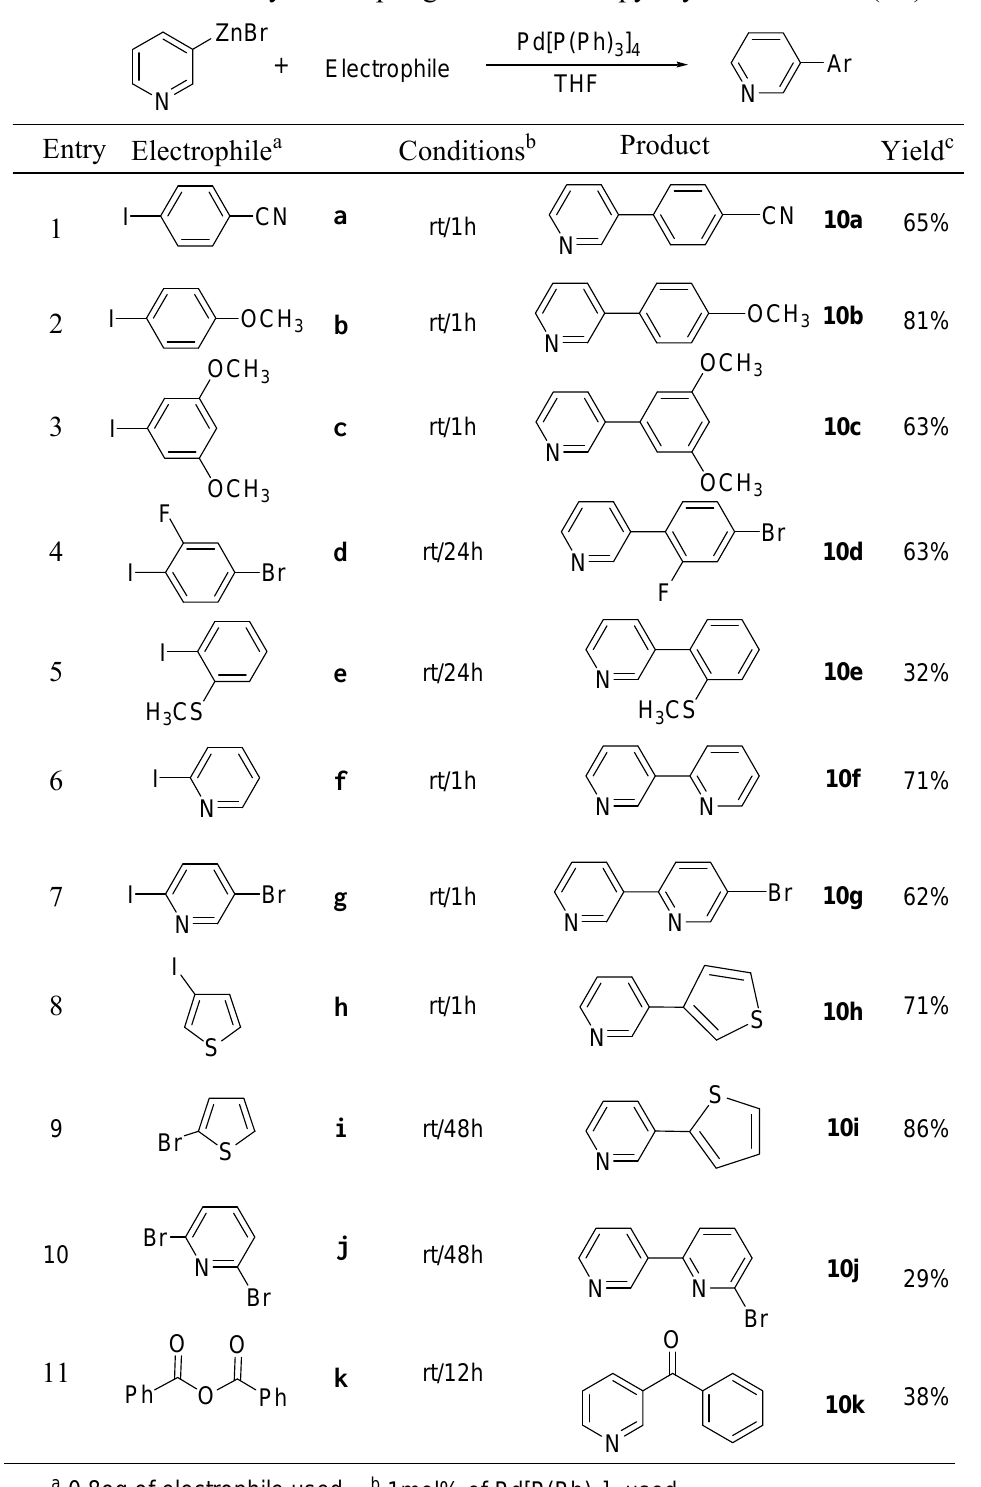
Table 10. Pd-Catalyzed coupling reactions of 3-pyridylzinc bromide ( P7